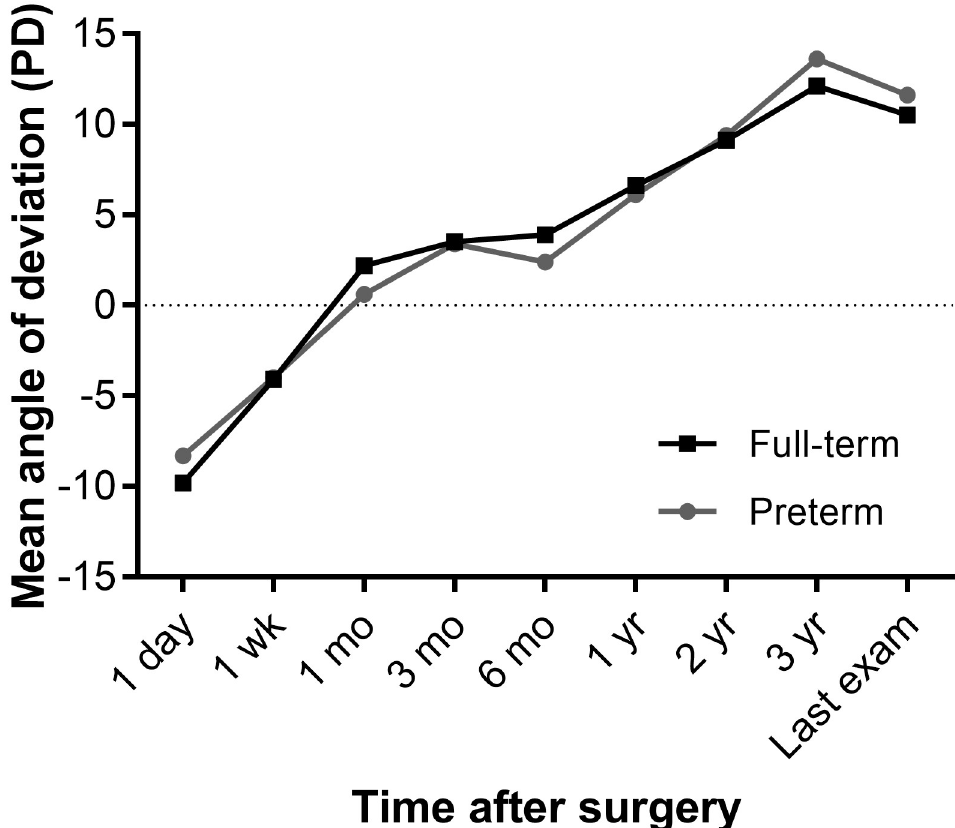
Fig 1. Postoperative angle of deviation according to postoperative duration between the pre-term and full-term groups. The effect of time on the angle of deviation from baseline (postoperative day 1) to final follow-up postoperatively was calculated using a linear mixed model analysis, which demonstrates a significant change in the angle of deviation over time (p < 0.001). However, the postoperative angles of deviation between the two groups are not different (p = 0.734), and a group × time interaction effect is also not found (p = 0.992).